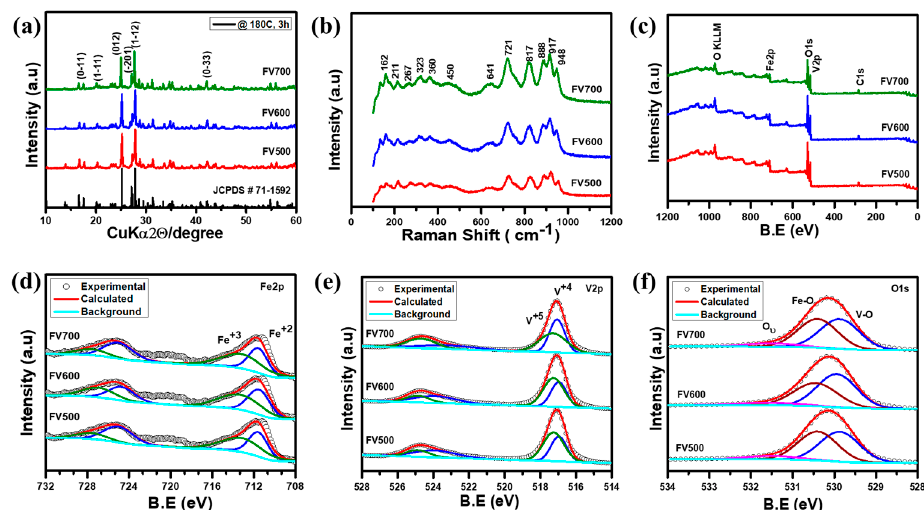
Figure 1. ( a ) XRD Analysis, ( b ) Raman spectroscopy analysis, ( c ) XPS survey spectrum, ( d ) XPS spectrum of Fe2p, ( e ) XPS spectrum of V2p, and ( f ) XPS spectrum of O1s of FV500, FV600, and FV700, respectively. Table 1. Summary of unit cell data and lattice parameters of FV500, FV600, and FV700, respectively. FeVO